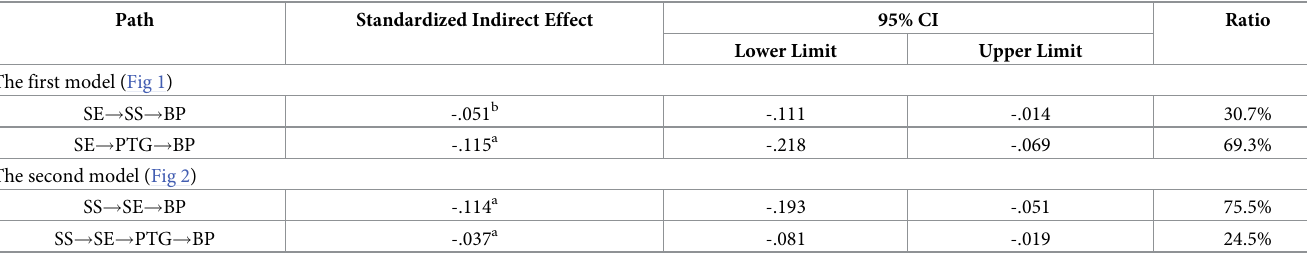
Table 4. Bootstrap analysis of mediating effect (N =